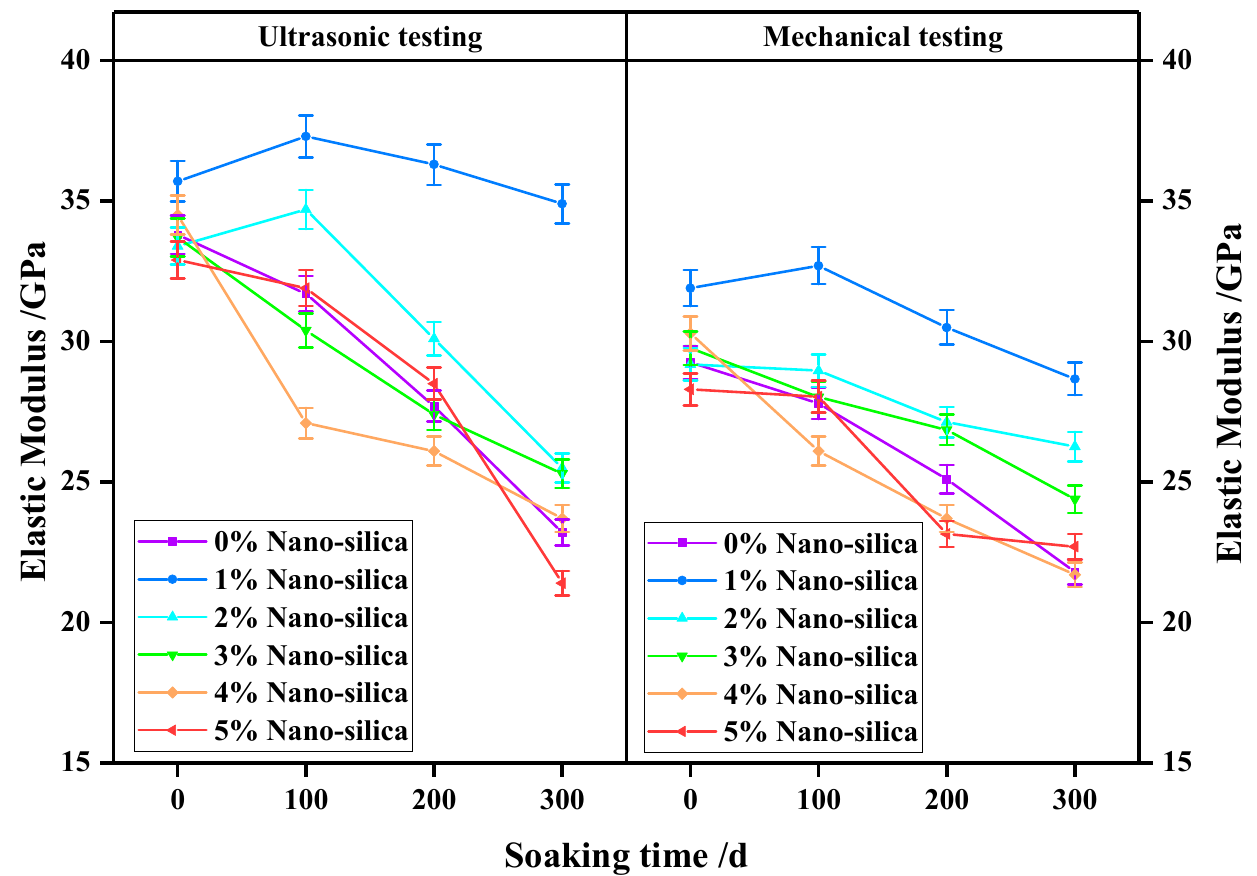
Figure 6. The time-dependent elastic modulus of HPC specimens obtained from ultrasonic and mechanical testing subject to sulfate attack.